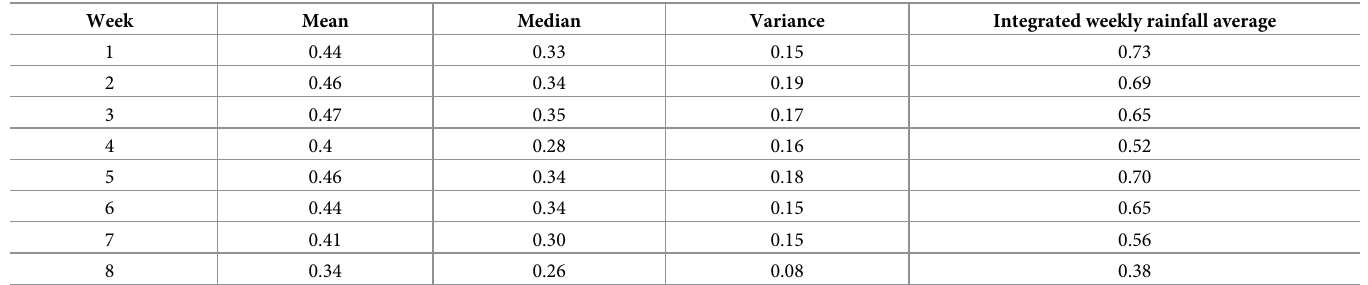
Table 1. Parameter estimations of daily precipitation and the integrated total precipitation by week (inch).